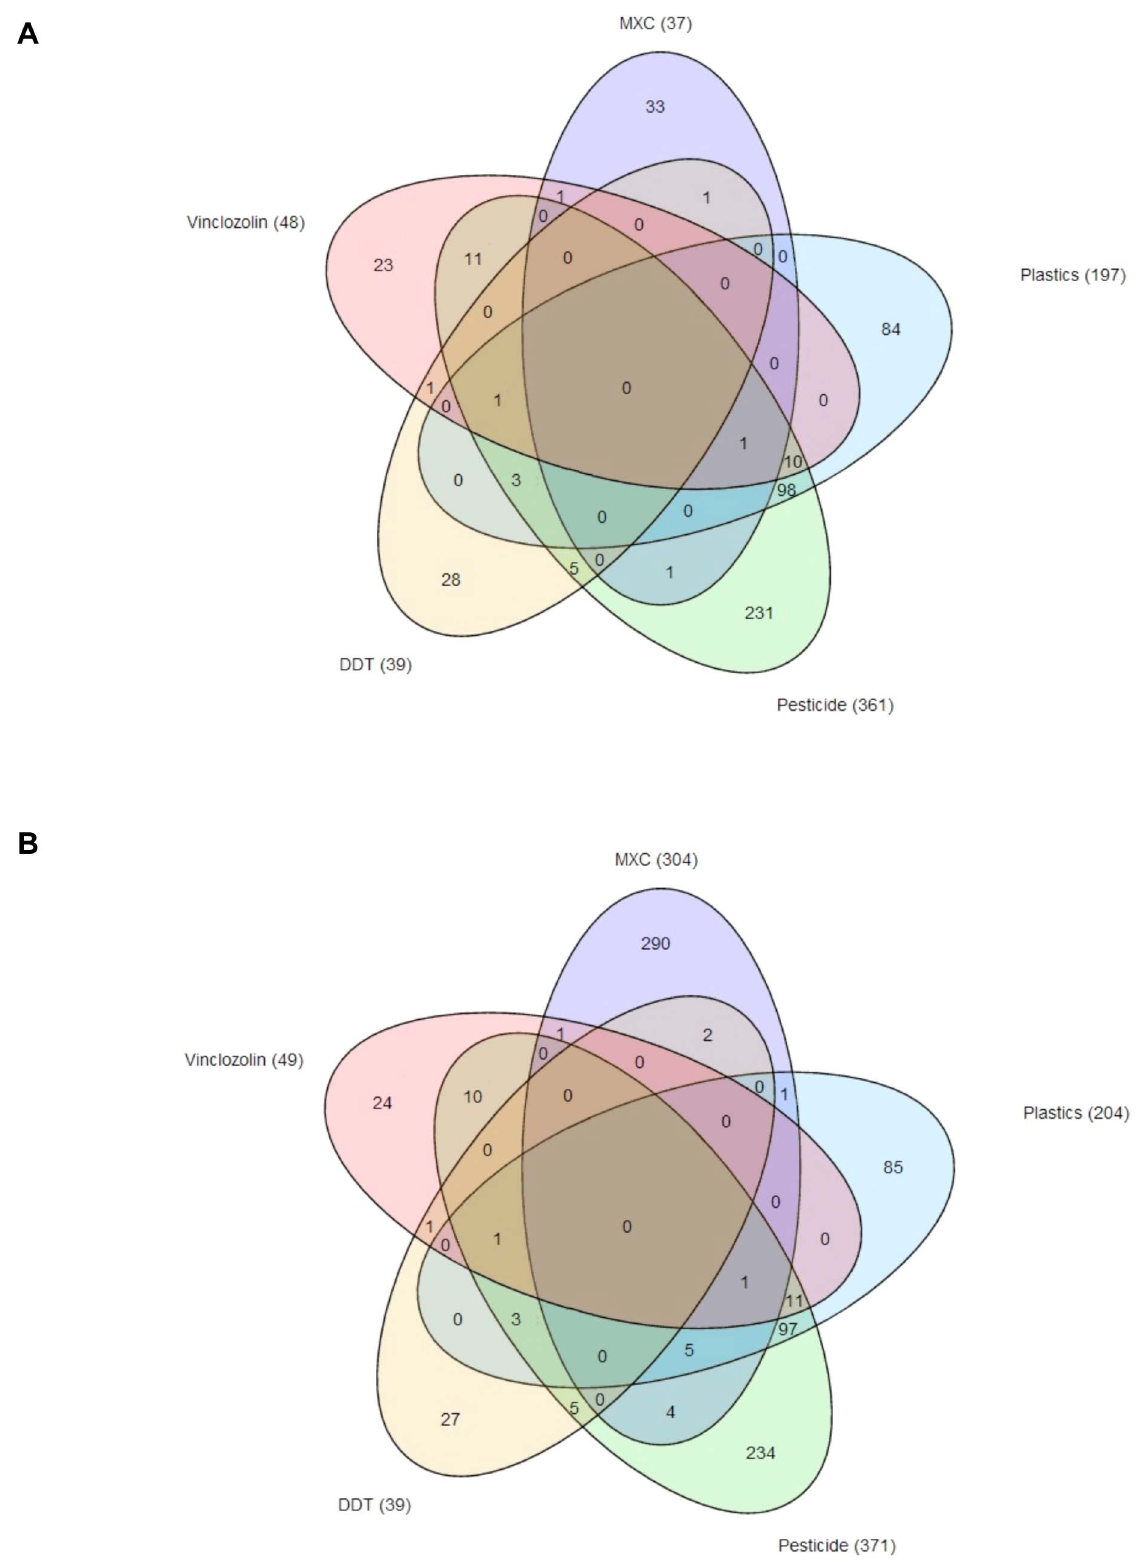
Figure 9. Exposure specific transgenerational sperm epimutations in methoxychlor, vinclozolin, DDT, pesticide (DEET and permethrin) and plastics (BPA and phthalates). A Venn diagram indicating the total number of intersection epimutations (A) and average epimutations (B) involving overlap between the various epimutation exposure data sets. Total number of epimutations for each exposure are in brackets next to label. doi:10.1371/journal.pone.0102091.g009 PLOS ONE |